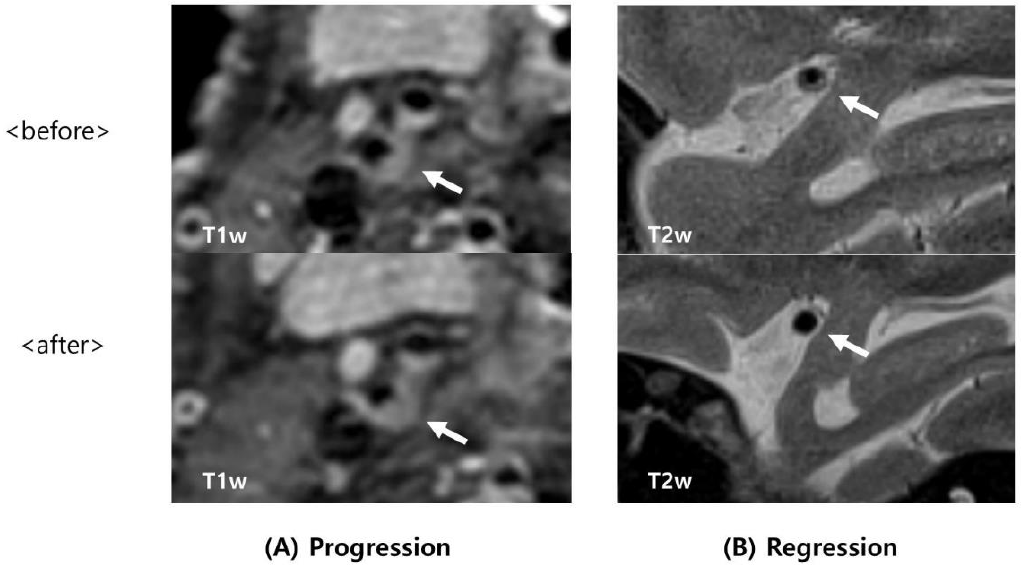
Figure 1. Examples of progression and regression of cerebral artery stenosis on HR-MRI. ( A , B ): Atherosclerotic plaque (arrow). ( A ) Upper panel: initial T1-weighted (T1w) HR-MR imaging reveals moderate stenosis in the right ICA; lower panel: follow-up T1w HR-MR imaging indicates severe stenosis in the right ICA. ( B ): Upper panel: initial T2-weighted (T2w) HR-MR imaging of the MCA with stenosis. Lower panel: follow-up T2w HR-MR imaging shows the MCA without stenosis. HR-MRI = high-resolution magnetic resonance imaging; ICA = internal carotid artery; MCA = middle cerebral artery.